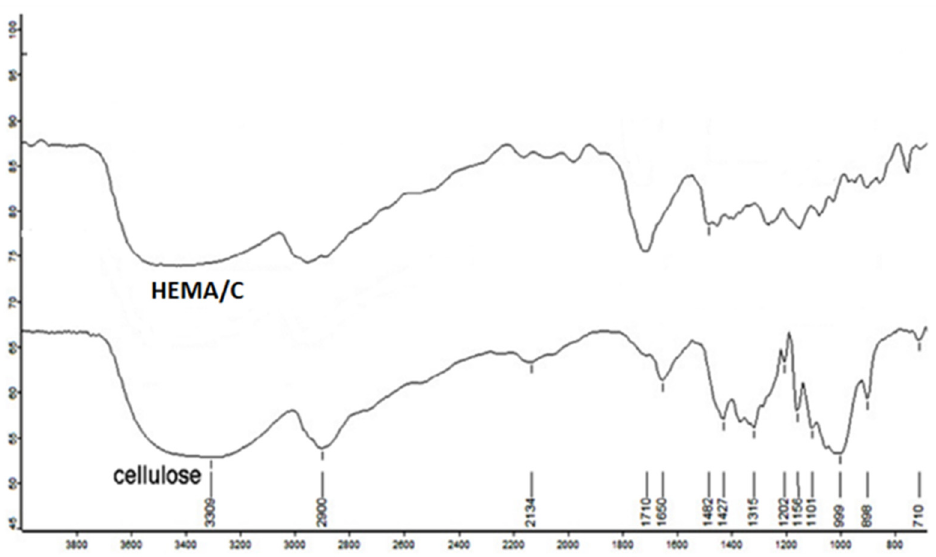
Figure 2. Fourier transform infrared spectra (FTIR) of cellulose and HEMA/C copolymer.